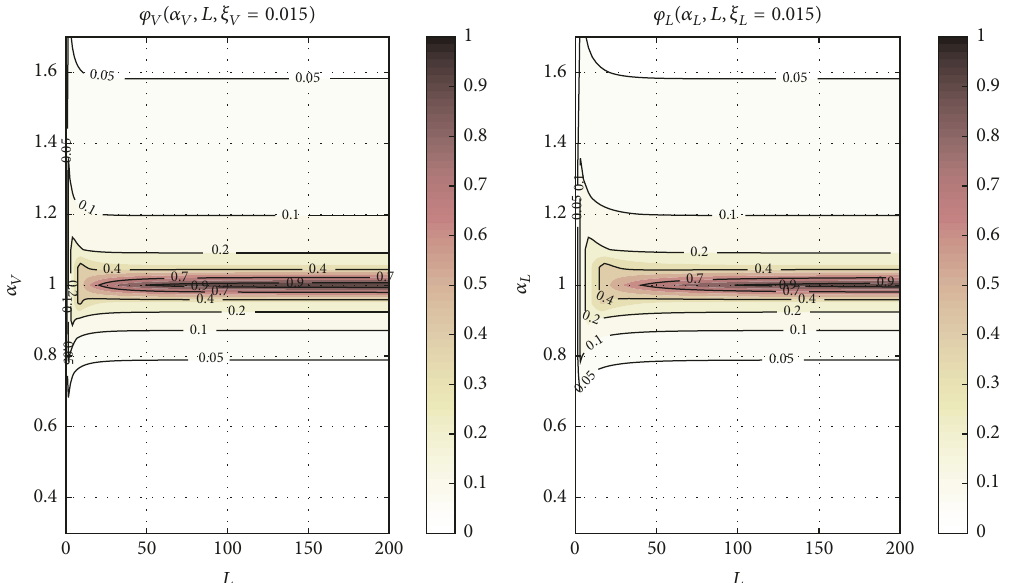
Figure 5: 𝜑 𝑉 (𝛼 𝑉 ,𝐿,𝜉 𝑉 = 0.015) and 𝜑 𝐿 (𝛼 𝐿 ,𝐿,𝜉 𝐿 = 0.015) for the simply supported beam evaluated using (19).